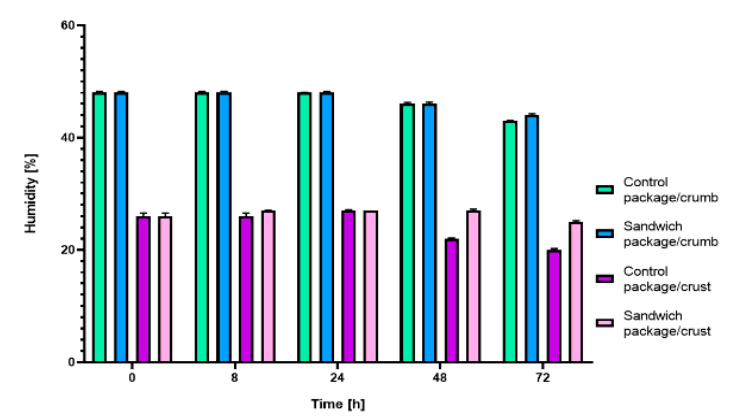
Figure 6. Humidity of the crust and crumb after storage in paper and in the modified packaging.